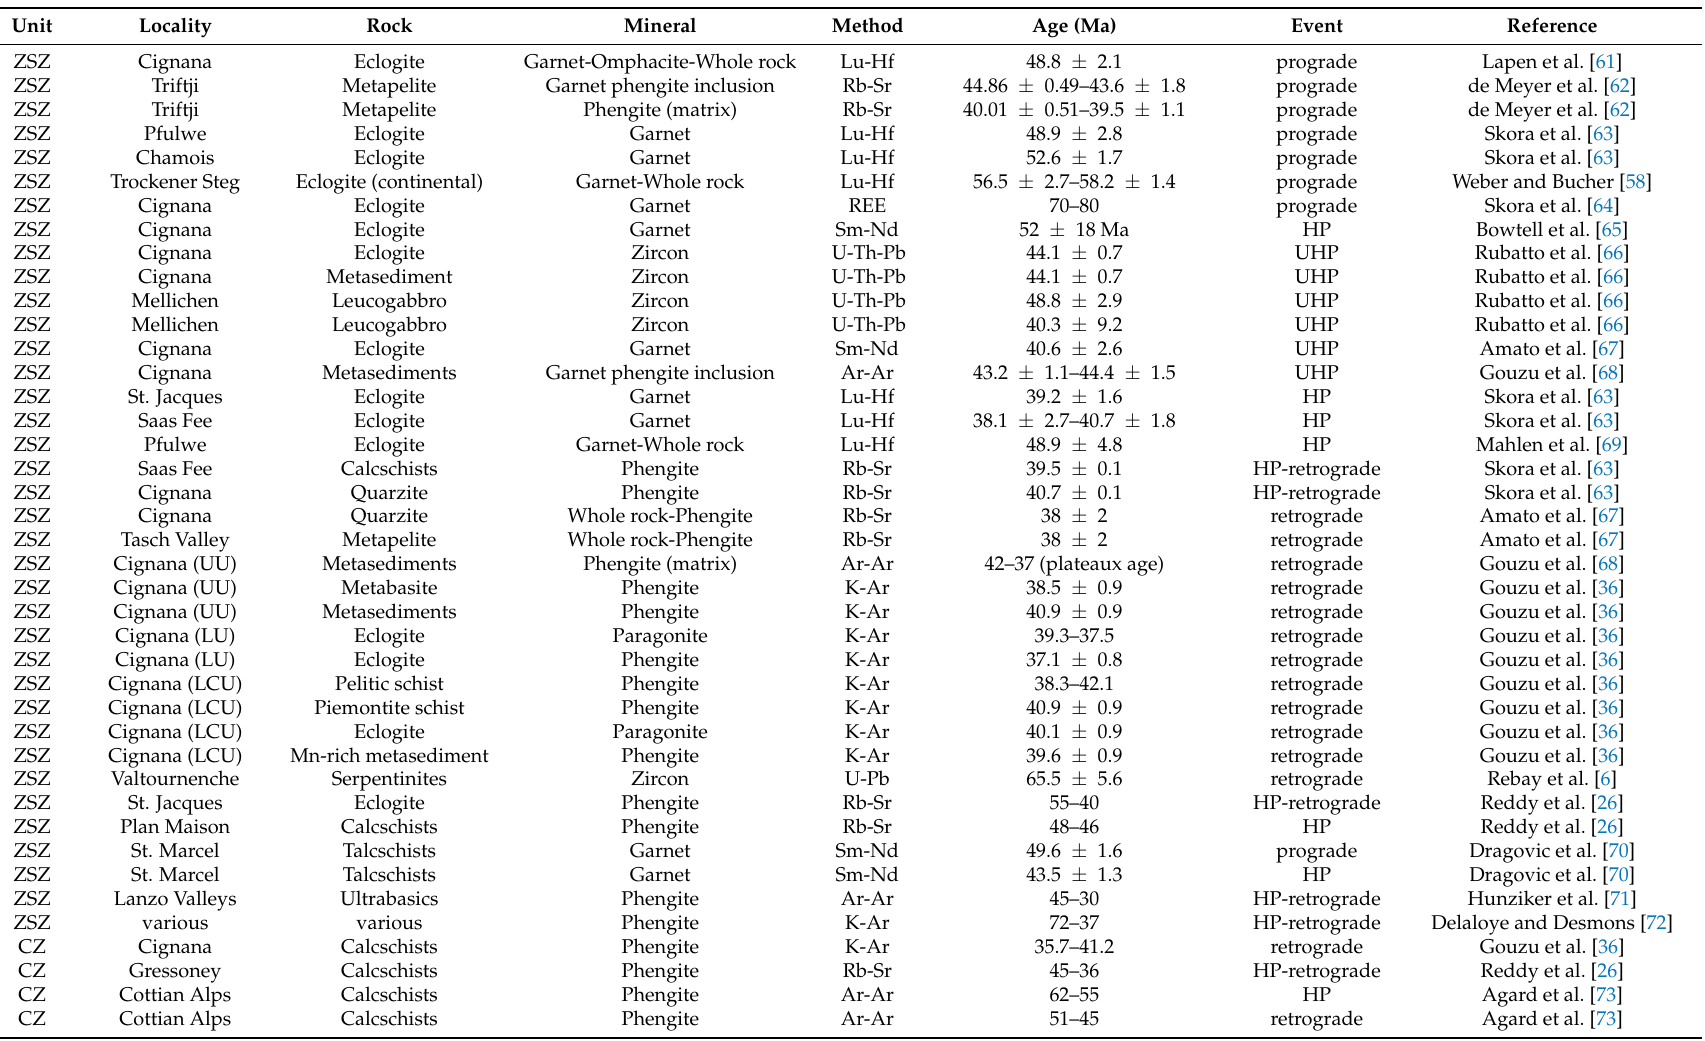
Table 1. Summary of age data for peak P-T conditions of PZ ophiolites. ZSZ=Zermatt-Sass Zone, CZ=Combin zone, A=Antrona, Mv=Monviso, VM=Voltri